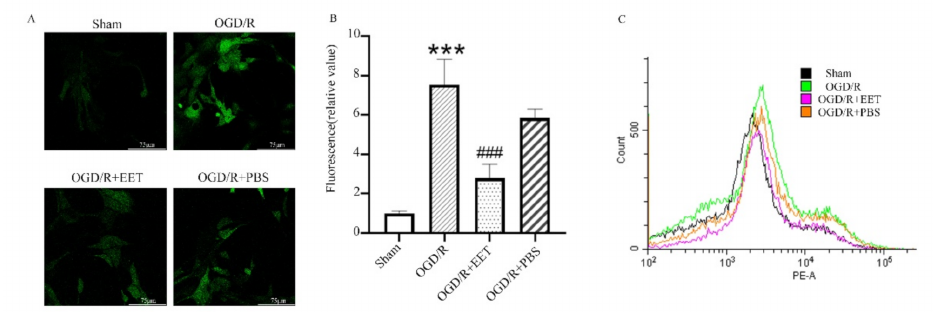
Figure 6. 14,15-EET reduced ROS production induced by OGD/R in cortical neurons. ( A ) The generation of ROS was measured with DCFH-DA by confocal laser scanning microscopy in primary cortical neurons at 24 h after OGD/R. ( B ) Statistical analysis of fluorescence intensity of ROS in primary cortical neurons at 24 h after OGD/R. ( C ) Mitochondrial reactive oxygen species were measured with MitoSOX Red staining by flow cytometry. (*** p < 0.001 vs. sham; ### p < 0.001 vs. OGD/R; n =